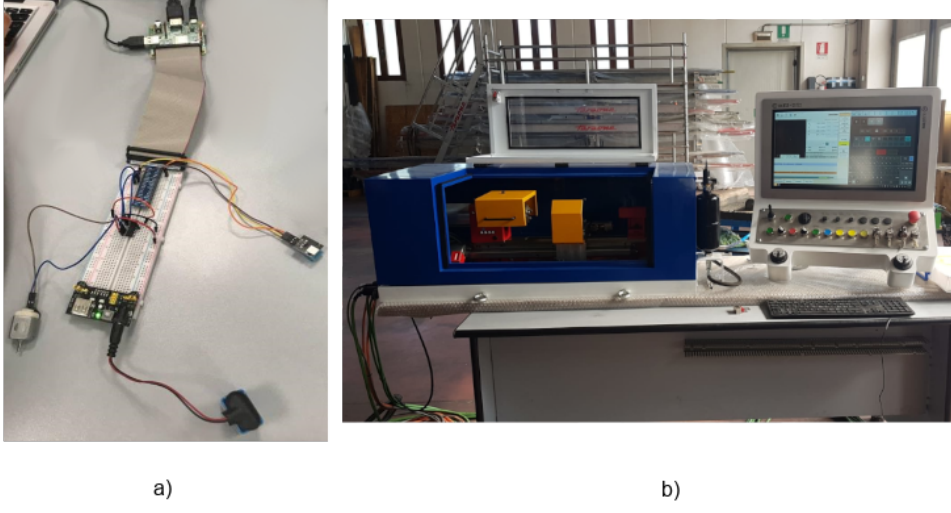
Figure 2. First ( a ) and Second ( b ) Prototype of the MwISM